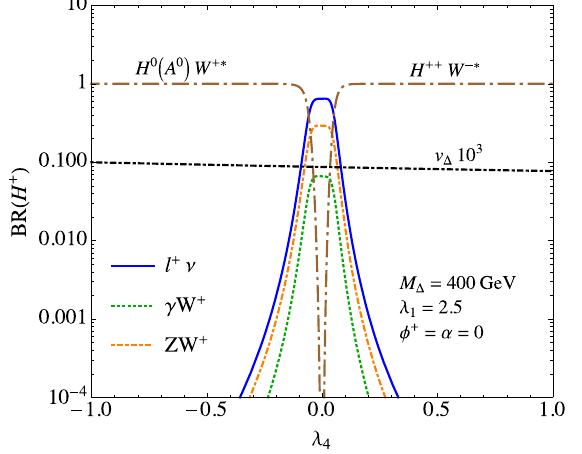
Figure 13 . BRs for H + decaying to ‘ + (cid:23) , (cid:13)W + , ZW + , H ++ W (cid:0)(cid:3) , and SW + (cid:3) , where (cid:30) + = (cid:11) = 0, M (cid:1) = 400 GeV, and (cid:21) 1 = 2 : 5 are